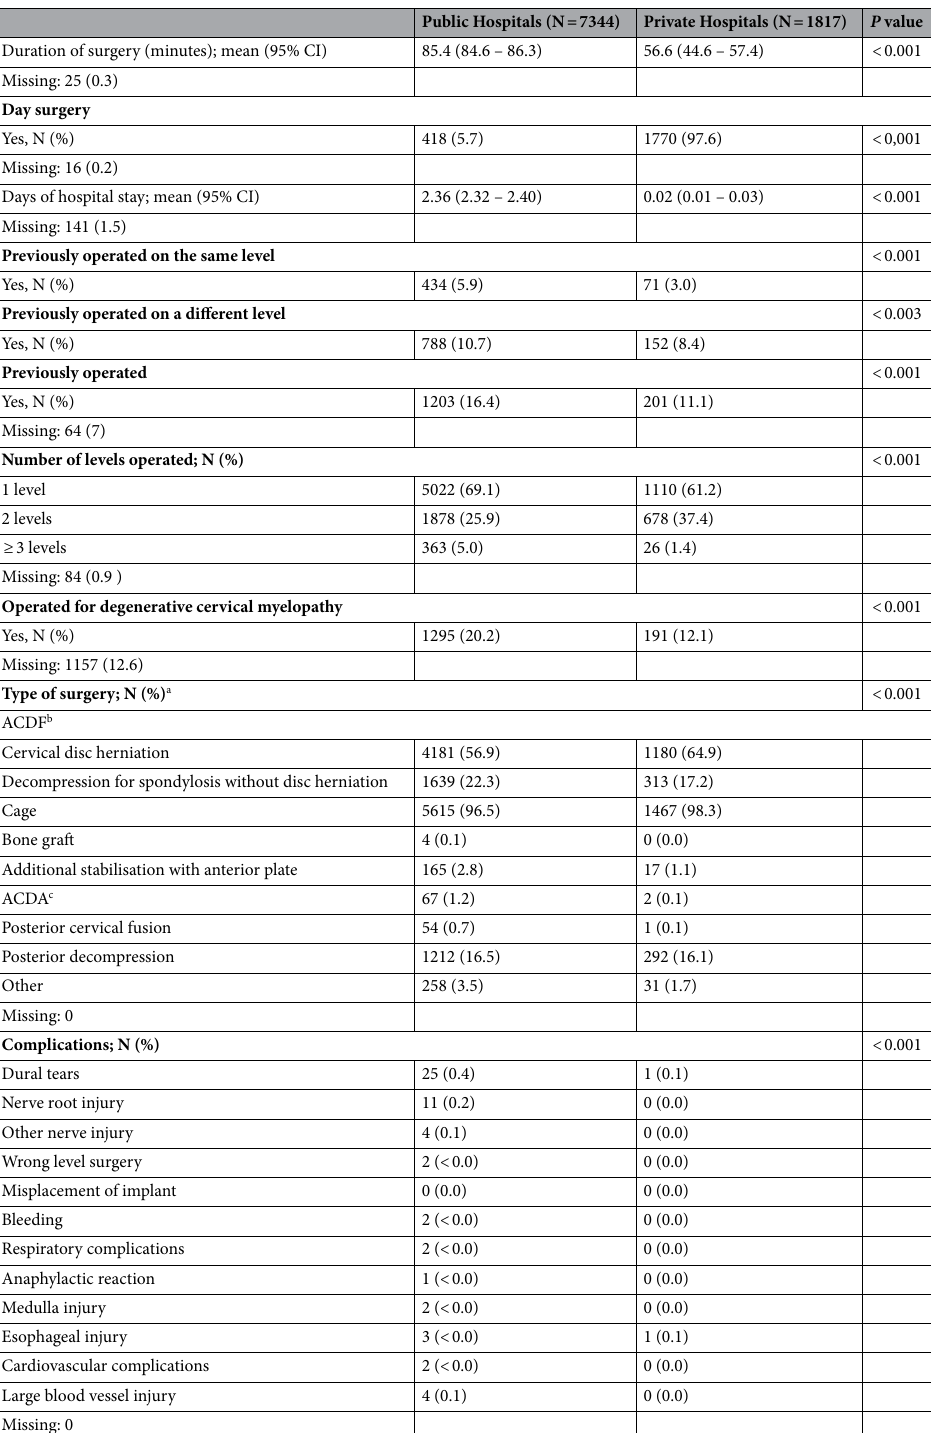
Table 3. Surgical characteristics of patients operated for cervical degenerative disorders in public and private hospitals. a Some patients can have more than one type of surgery. b Anterior cervical discectomy and fusion. c Anterior cervical disc